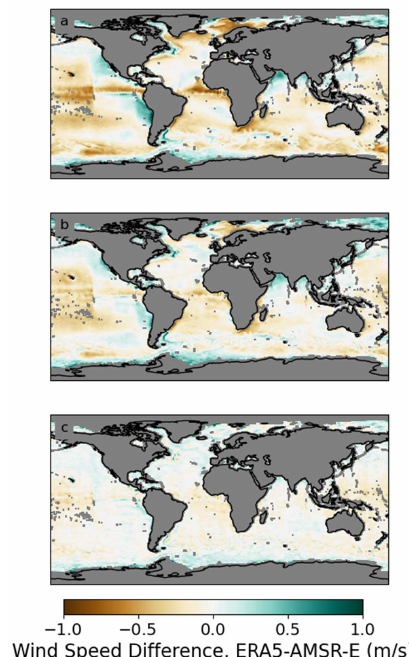
Figure A3. Similar to Figure 7 in the main text, except for ASCAT-A. Hovmöller diagrams of ERA5—ASCAT-A wind differences for 2000–2009. Panels ( a – c ) show the differences for zonal wind, meridional wind, and wind speed when only the ocean current adjustments are applied to ERA5. Panels ( d – f ) show the same differences after the wind speed adjustment was applied. Panels ( g – i ) shown the final results after location-dependent vector-component biases are also removed.